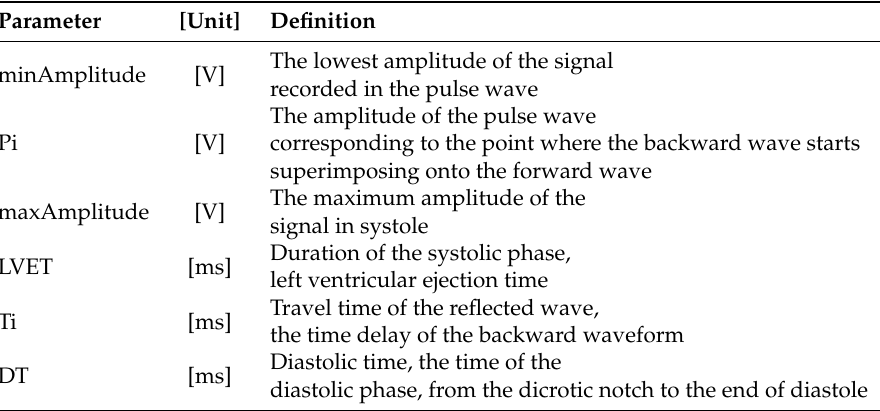
Table 1. List of parameters measured experimentally.